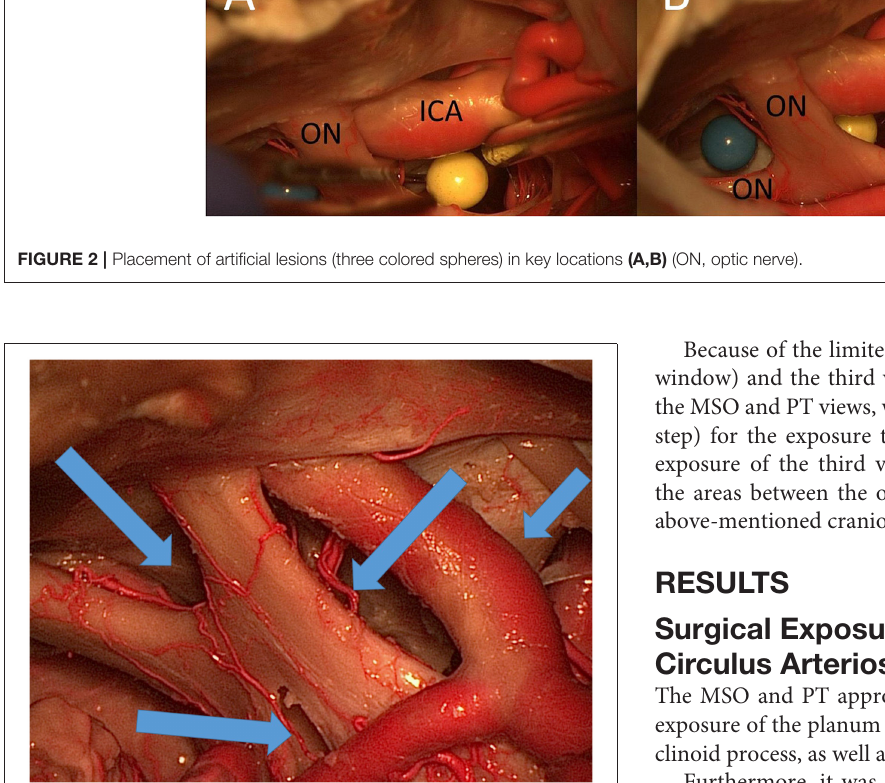
The surgical exposures of the artificial lesions using the four corridors were compared between the MSO and PT approaches. The bony flaps were alternatingly refixed and removed to allow direct comparison of the MSO and PT approaches. The two approaches were compared with regard to the surgical access to the spheres (from the maximal lateral and medial working angles) and the surgical exposure of the third ventricle (through the lamina